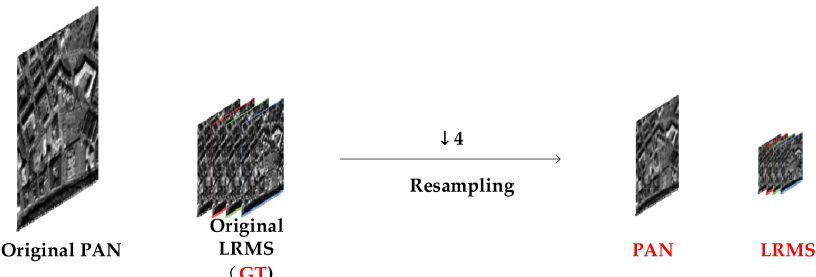
Figure 10. The process of generating a training dataset according to Wald’s protocol. The data represented by the red text are used for simulated experiments, whereas the data represented by the black text are used for real experiments.